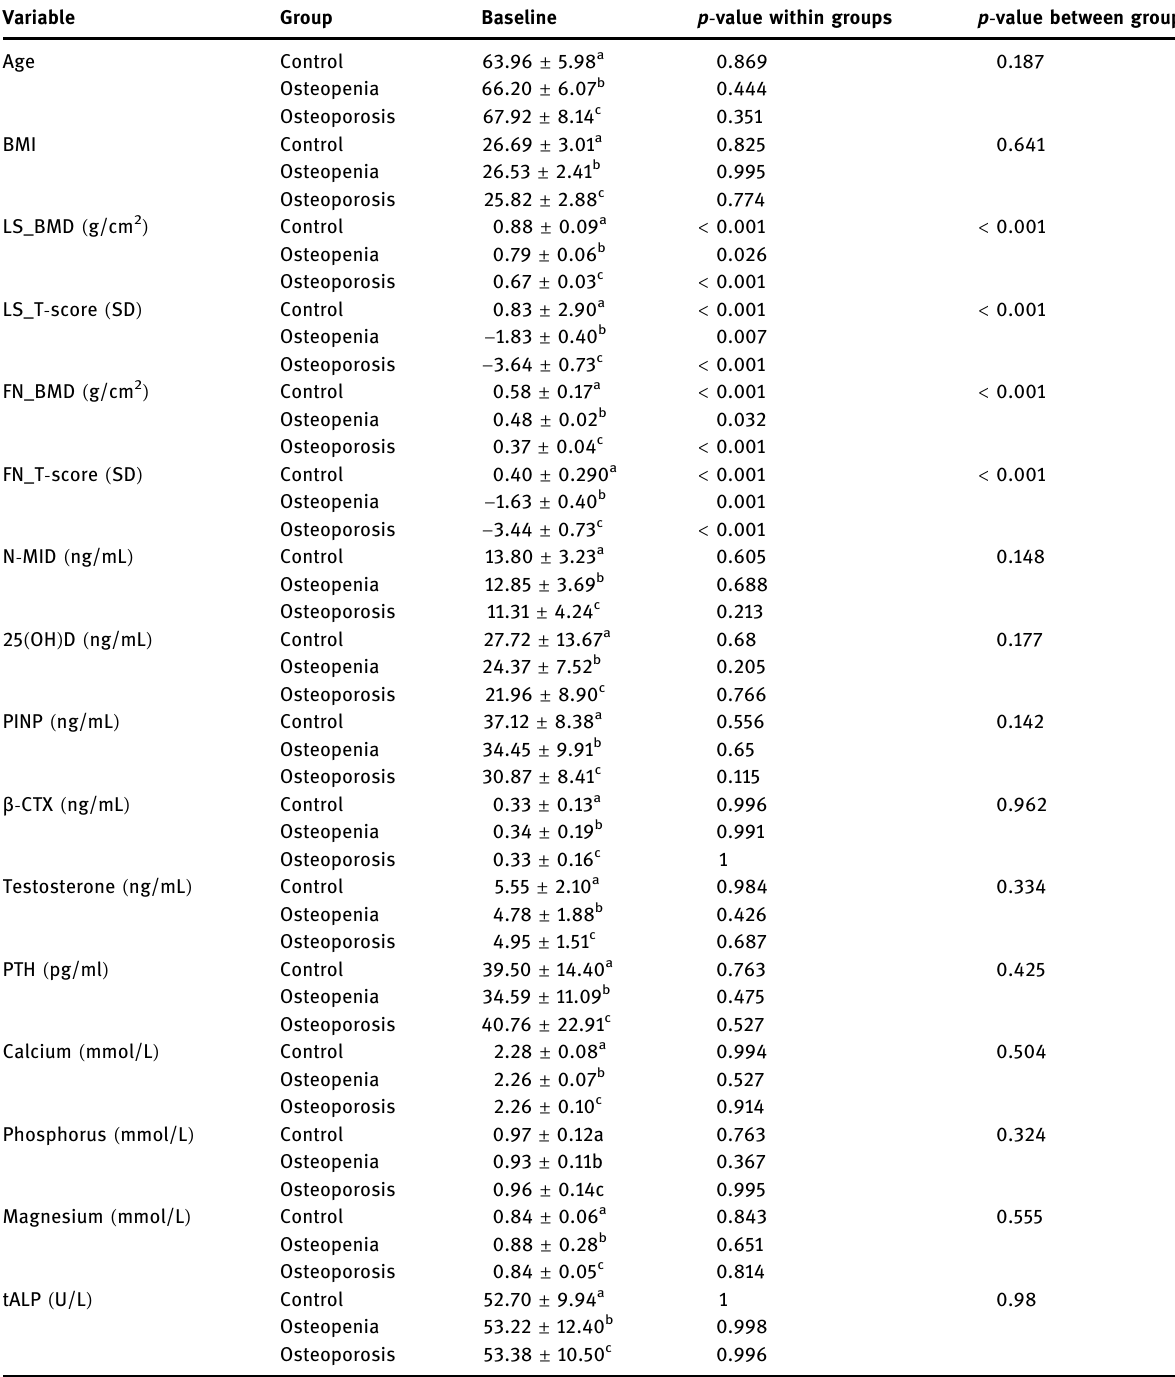
Table 1: Baseline comparative data of osteoporosis, osteopenia, and control groups